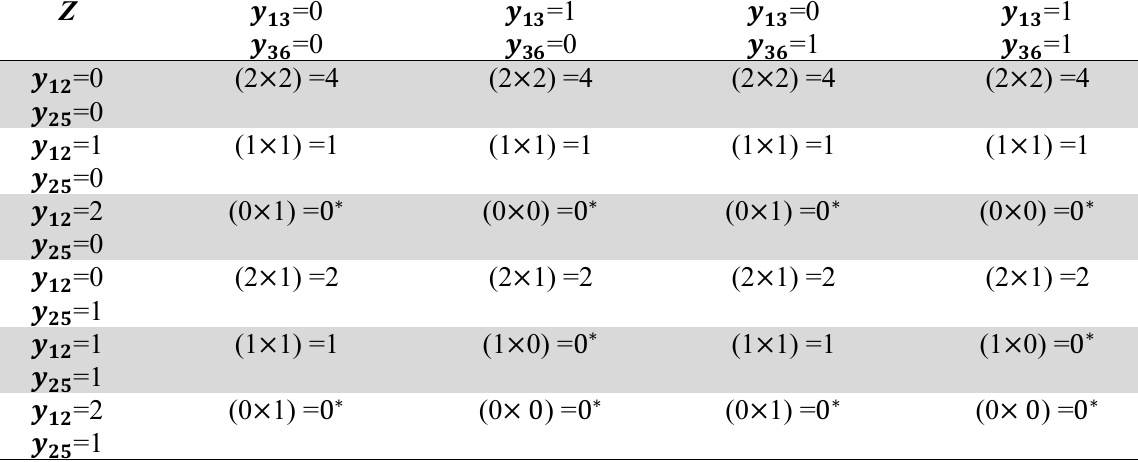
The matrix of Nash bargaining